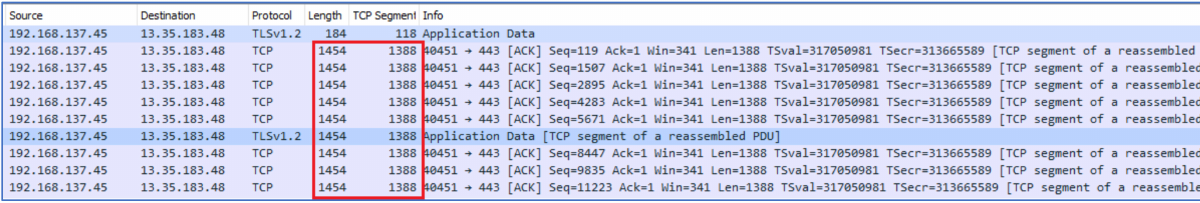
Figure 15. Traffic patterns for all type of media messages.